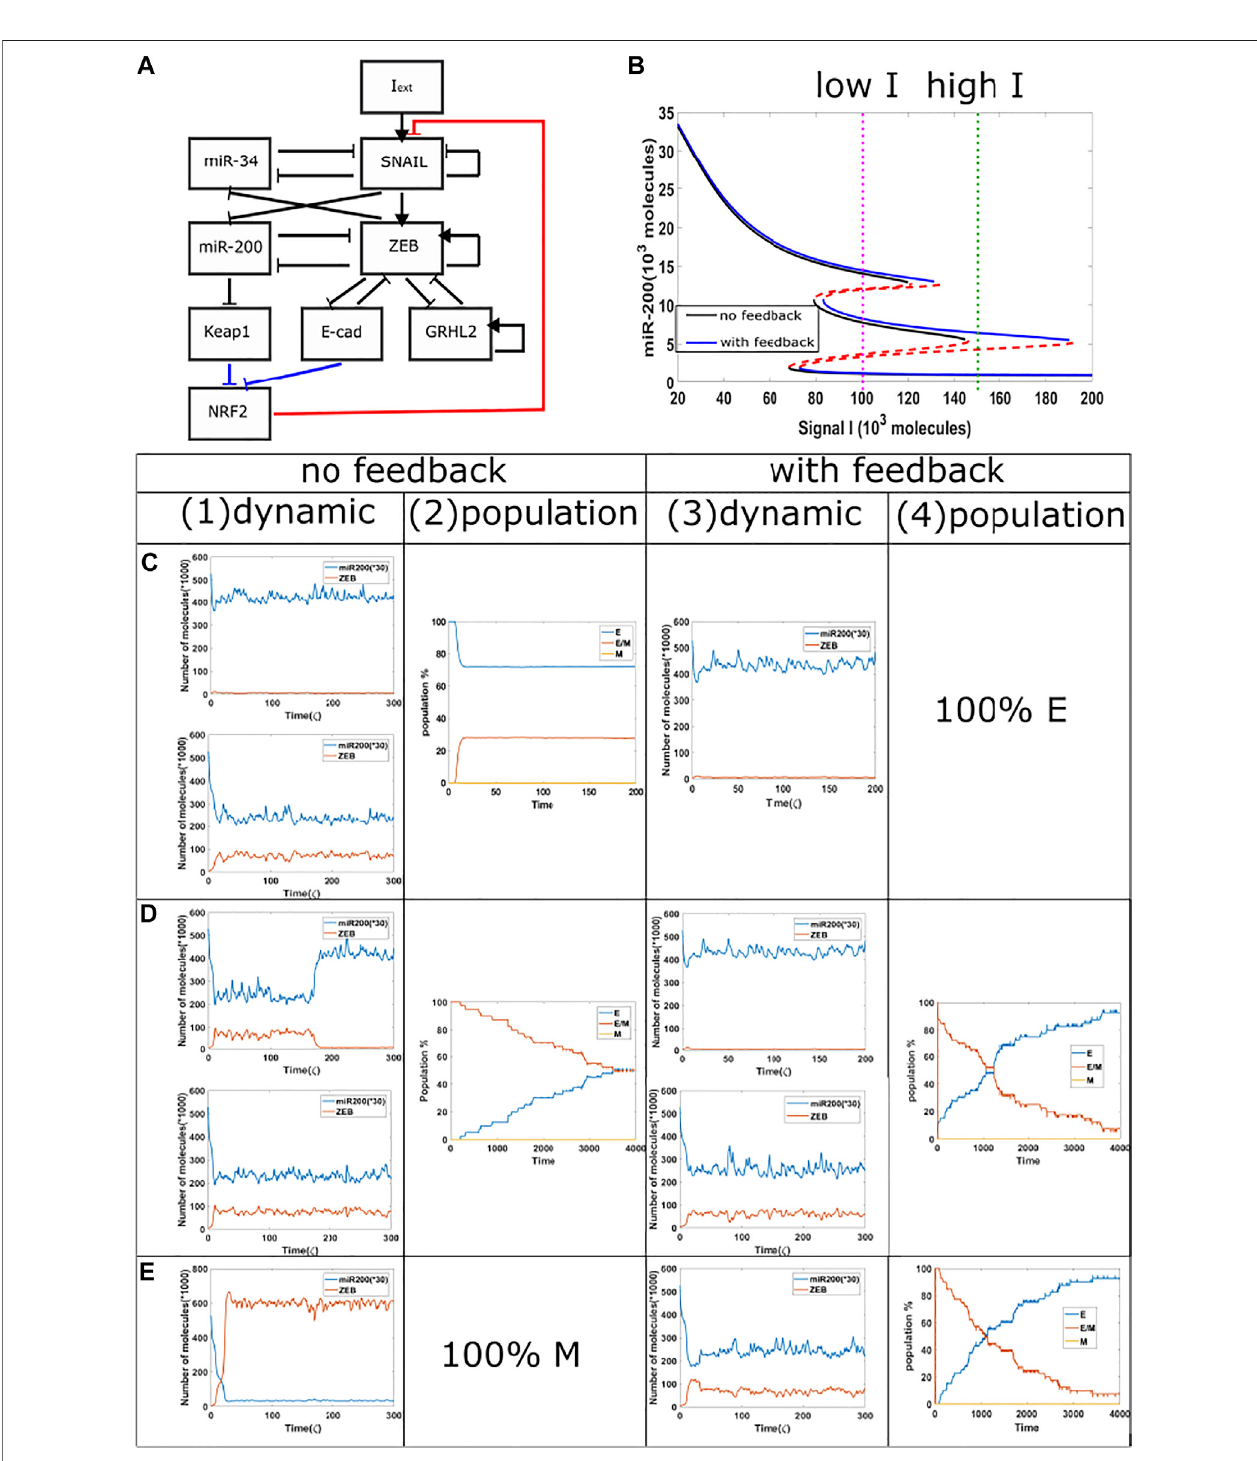
FIGURE 4 | Population dynamics for the circuit including GRHL2 with/without epigenetic feedback. (A) New circuit with GRHL2. (B) Same as Figure 3A , purple dottedlinerepresentslowsignal,and greendottedlinerepresentshighsignal. (C) Startingfrom I (cid:1) 170 K molecules, weshowdynamicexamples and population results for models with or without epigenetic feedback obtained by reducing the signal I to 102 K molecules after short high signal durations (high signal ending time (cid:1) 4 ς ). (D) Same as Figure 3C with high signal ending time (cid:1) 10 ς . (E) Same as Figure 3C with high signal ending time (cid:1) 30 ς .